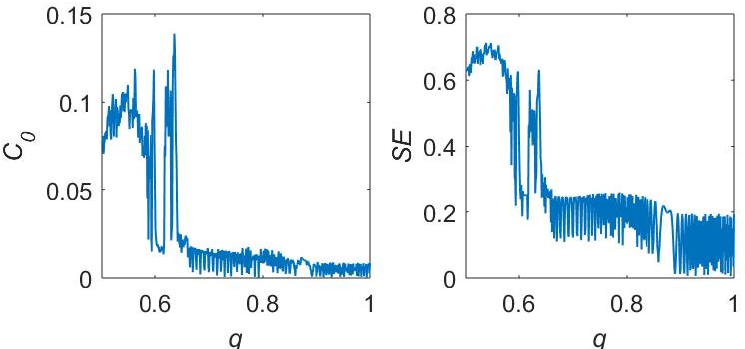
11 of 19 1 q = 0.75 q = 0.7 q = , , and when 1 q = 0.75 q = 0.7 q = , , and when